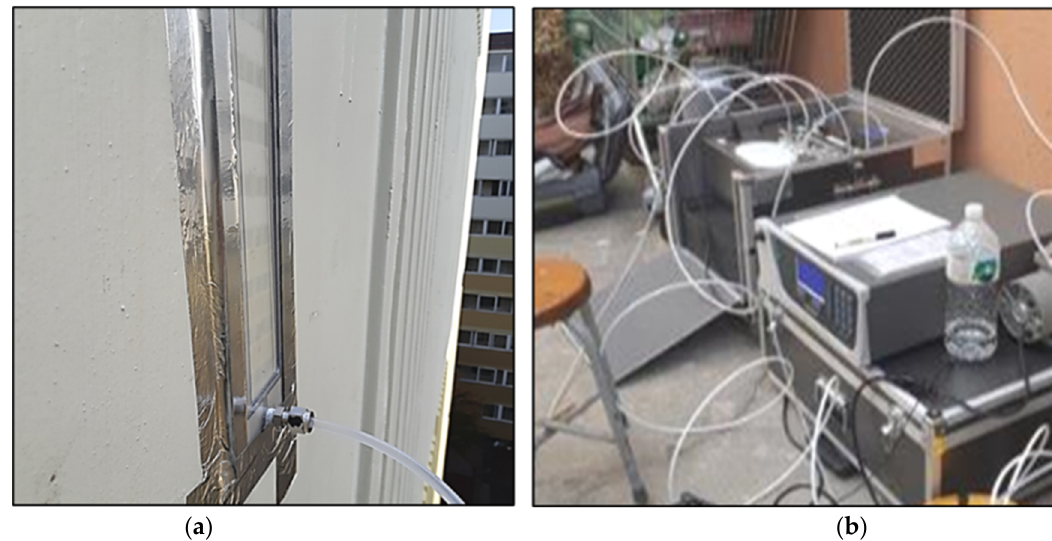
Figure 3. The experimental setup of photoreactor experiment on the wall. ( a ) Photoreactor with NO gas injection hoses on the eastern wall; ( b ) portable analysis device for NOx removal.